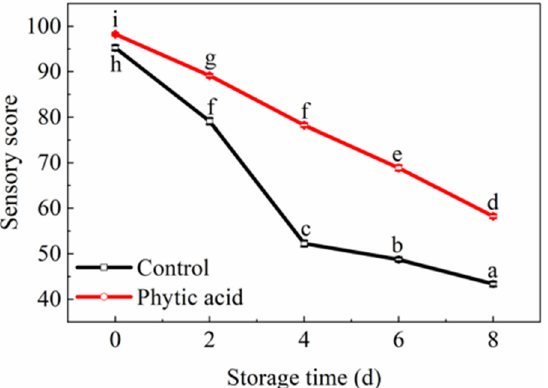
Figure 1. Sensory evaluation of fresh-cut apples during storage after treatment with phytic acid or the control. Vertical bars represent standard errors of the means of eight replicates. The different letters indicate significant differences at p < 0.05.